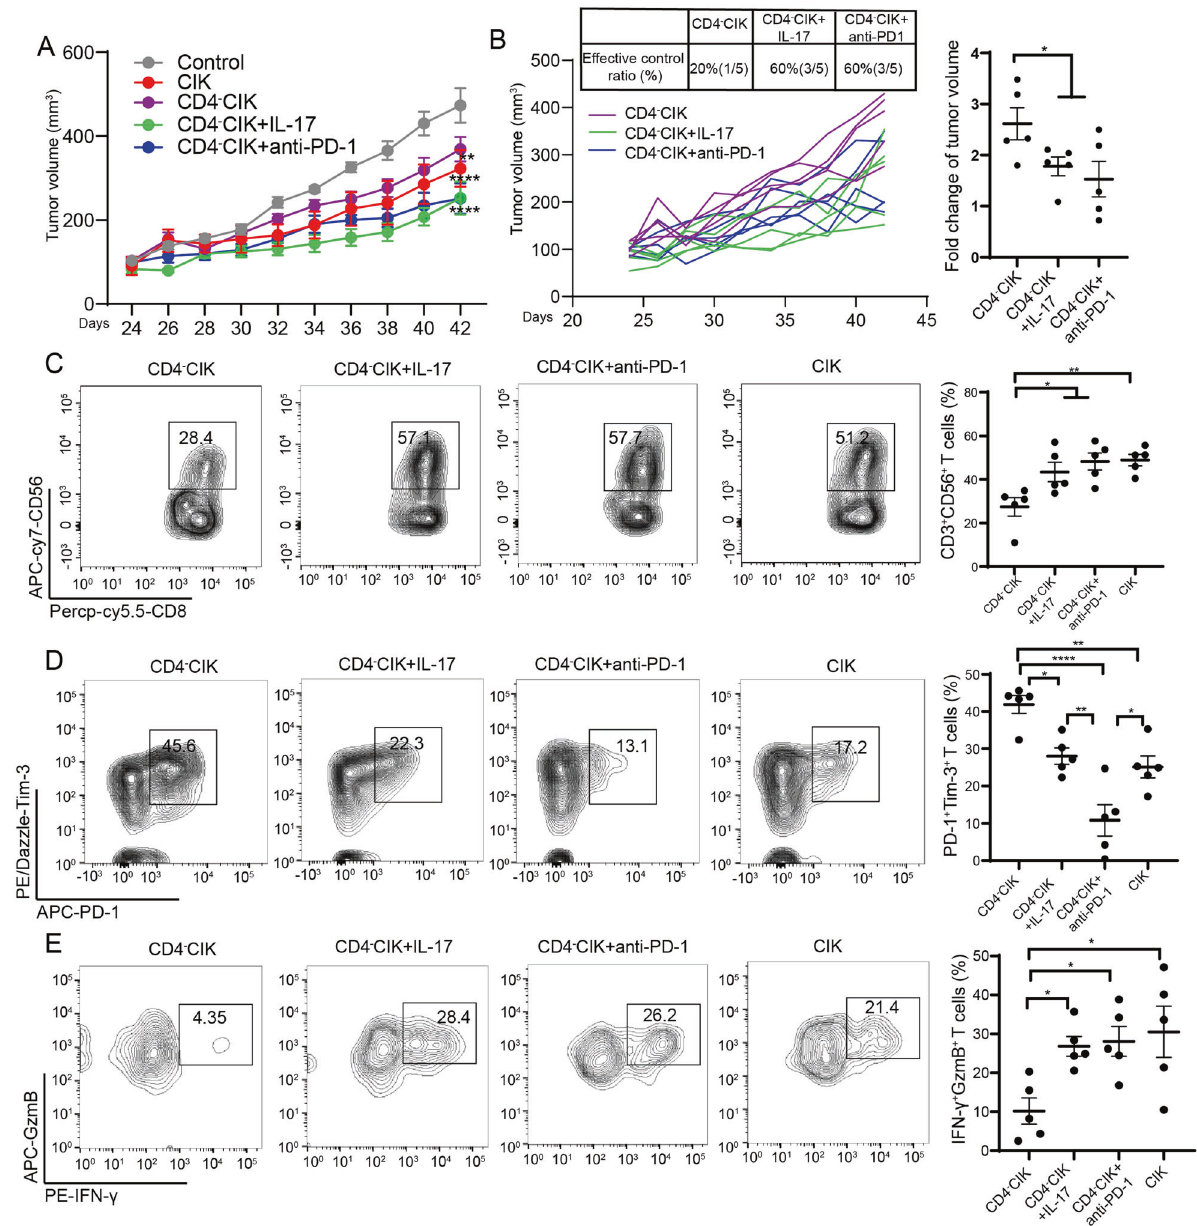
Fig. 6 CIK cell therapy plus IL-17A or anti-PD-1 treatment reversed the functions of exhausted CIK cells in vivo. A , B Subcutaneous growth of tumor cells (A549) in each group of NSG mice treated with CD4 - CIK cells ( n = 5), CD4 - CIK cells + anti-PD-1 ( n = 5), CD4 - CIK cells + rIl-17 ( n = 5), or CIK cells ( n = 5). C Flow cytometric examination of the percentage of CD3 + CD8 + CD56 + T cells in CD3 + CD8 + T cells. D Flow cytometric analysis of the percentage of PD-1 + Tim-3 + CD8 + T cells in CD3 + CD8 + T cells. E Flow cytometric determination of the percentage of GzmB + IFN- γ + CD8 + T cells in CD3 + CD8 + T cells. Error bars indicate SEM, * P < 0.05, ** P < 0.01, *** P < 0.001, and **** P < 0.0001 (one-way ANOVA or Student's t